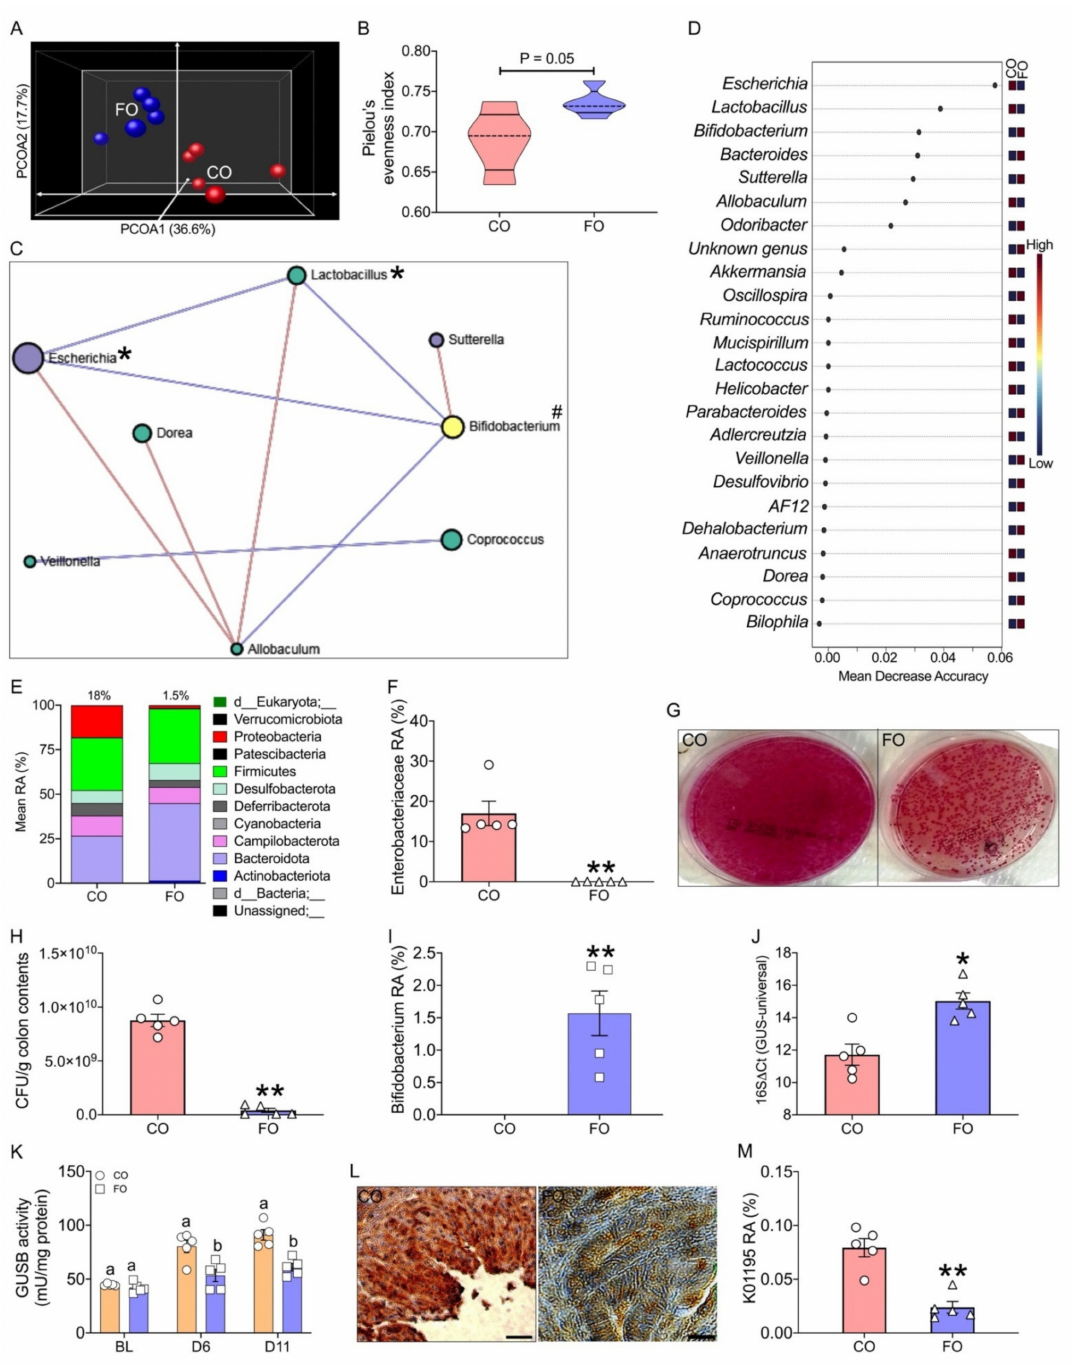
Figure 5. Dietary n-3 PUFA supplementation reduces CPT-11-induced alterations in the gut micro- biome . ( A ) Principal coordinates analysis (PCOA) plot showing the results of Bray–Curtis